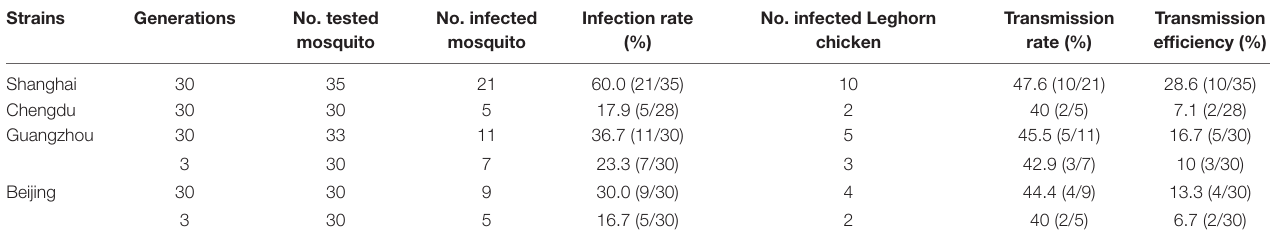
TABLE 1 | Infection rate and transmission rate and transmission efficiency of four geographical Aedes Albopictus strains after oral exposure to West Nile virus (WNV). Strains Generations